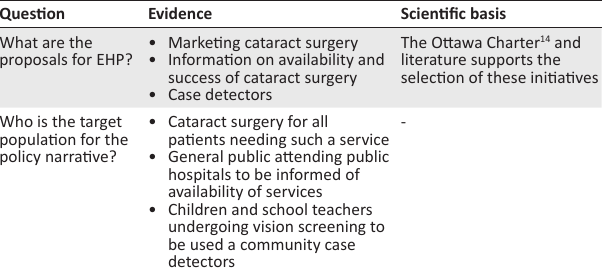
TABLE 4: Analysis of the guideline on cataract surgery in South